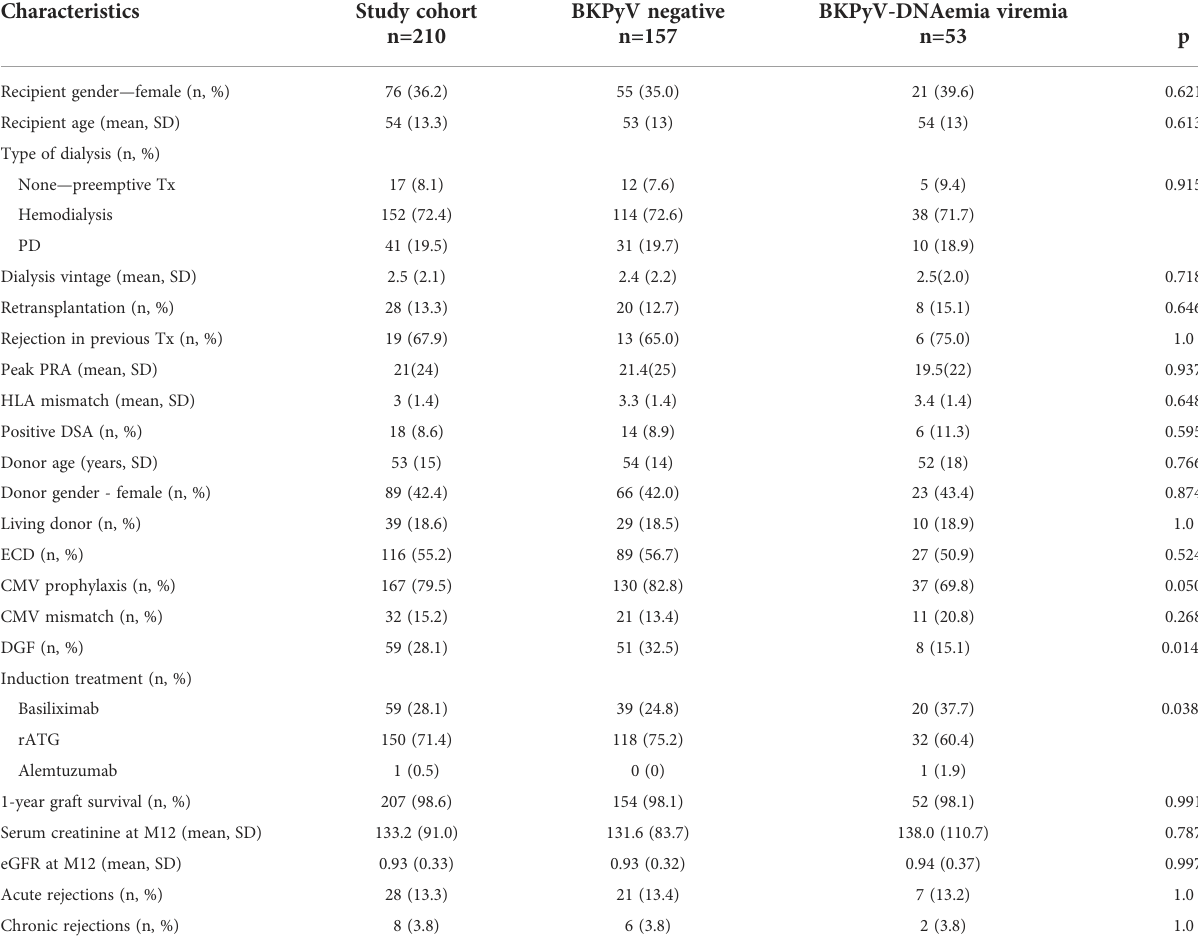
TABLE 1 Patients ’ demographic and clinical characteristics.